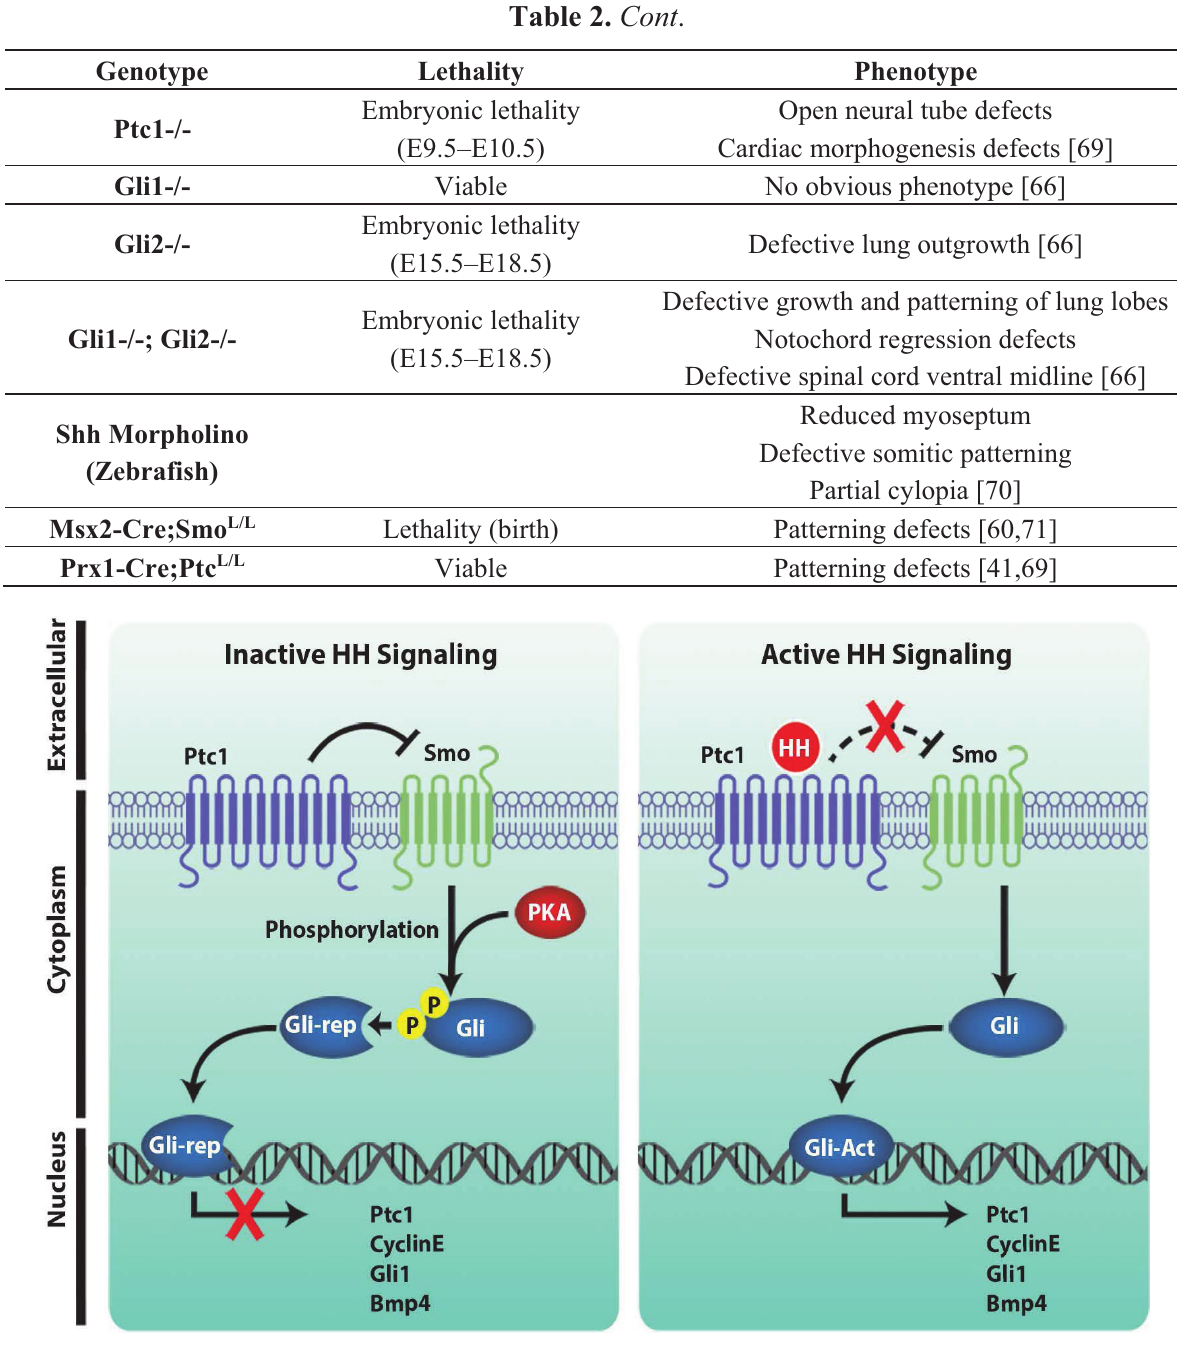
Figure 2. Schematic illustration of the HH signaling pathway. HH is a secreted morphogen which acts in an autocrine and paracrine fashion. In the absence of HH morphogen, Patched1 (Ptc1), a transmembrane protein, inhibits Smoothened (Smo) activity. Inhibition of Smo activity by Ptc1 has been hypothesized to involve a second messenger mediated mechanism. In the absence of Smo activity, protein kinase A (PKA) phosphorylates Gli proteins (a downstream target of HH signaling) leading to the generation of repressor Gli (Gli-rep), thereby resulting in inactive HH signaling. The binding of the HH morphogen results in loss of Ptc1 activity and subsequent activation of Smo activity. Activated Smo then transduces the signal, resulting in the activation of Gli2A (Gli-Act) and transcription of downstream